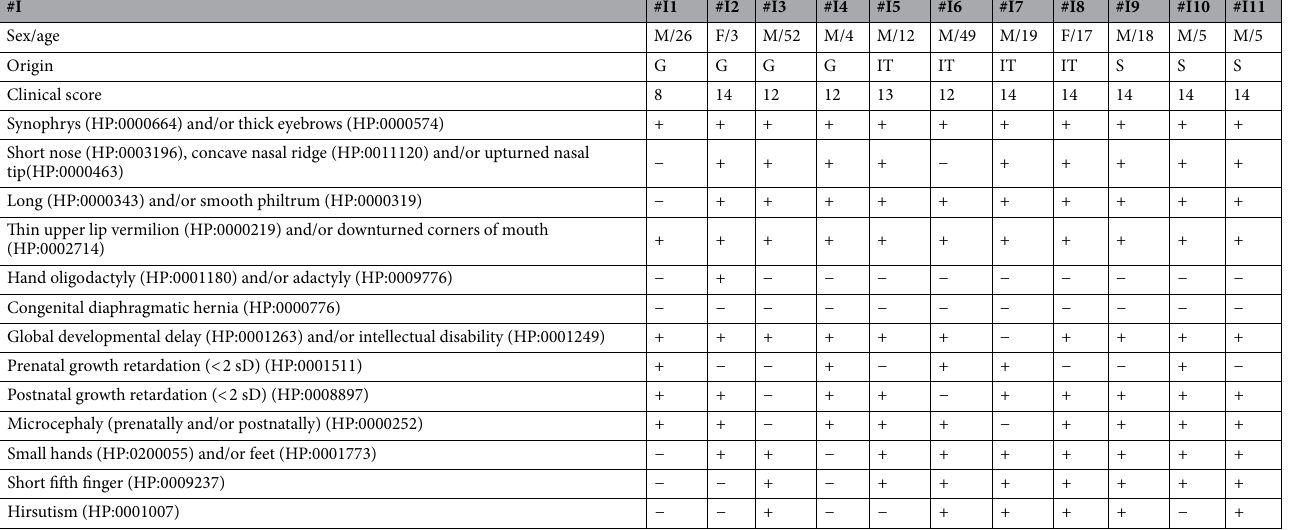
Table 1. Clinical findings of the 11 reported individuals with NIPBL mosaic variants. Abbreviations : I, Individual; M, male; F, female; +, positive; −, negative; G, Germany; IT, Italy; S,